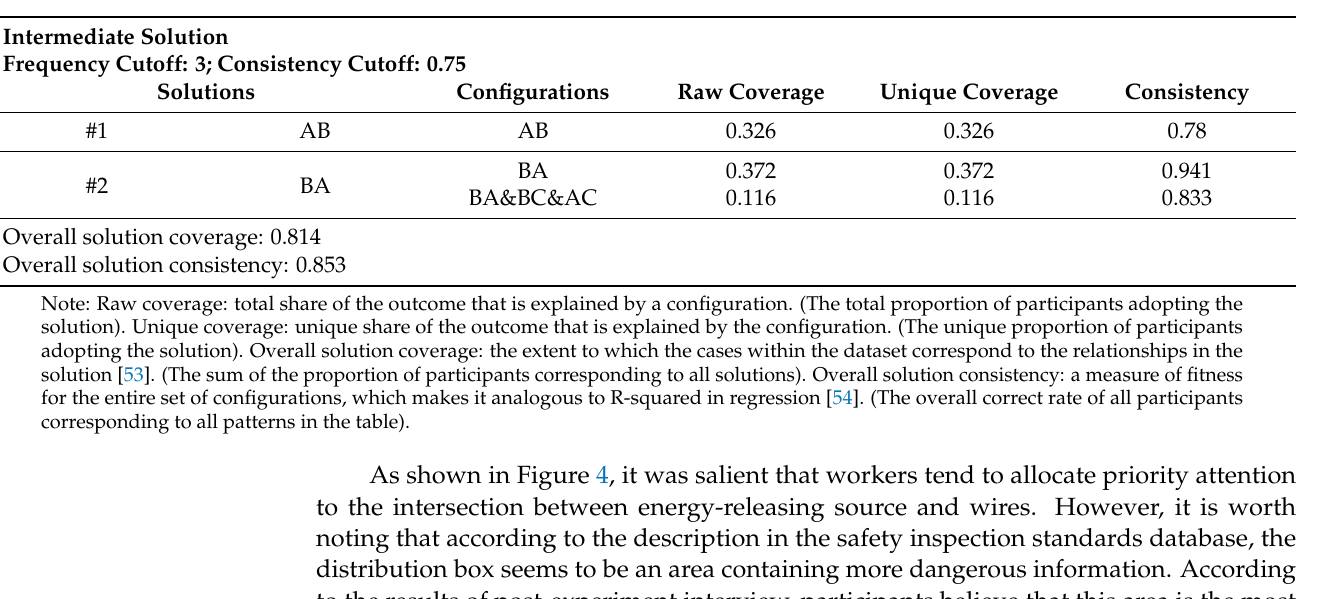
Table 4. Intermediate solution to correct recognition of Hazard